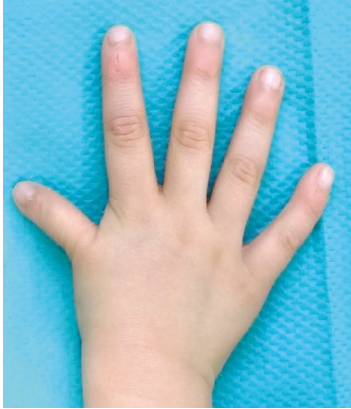
Figure 1: A 5-year-old boy with a hypoplastic thumb.